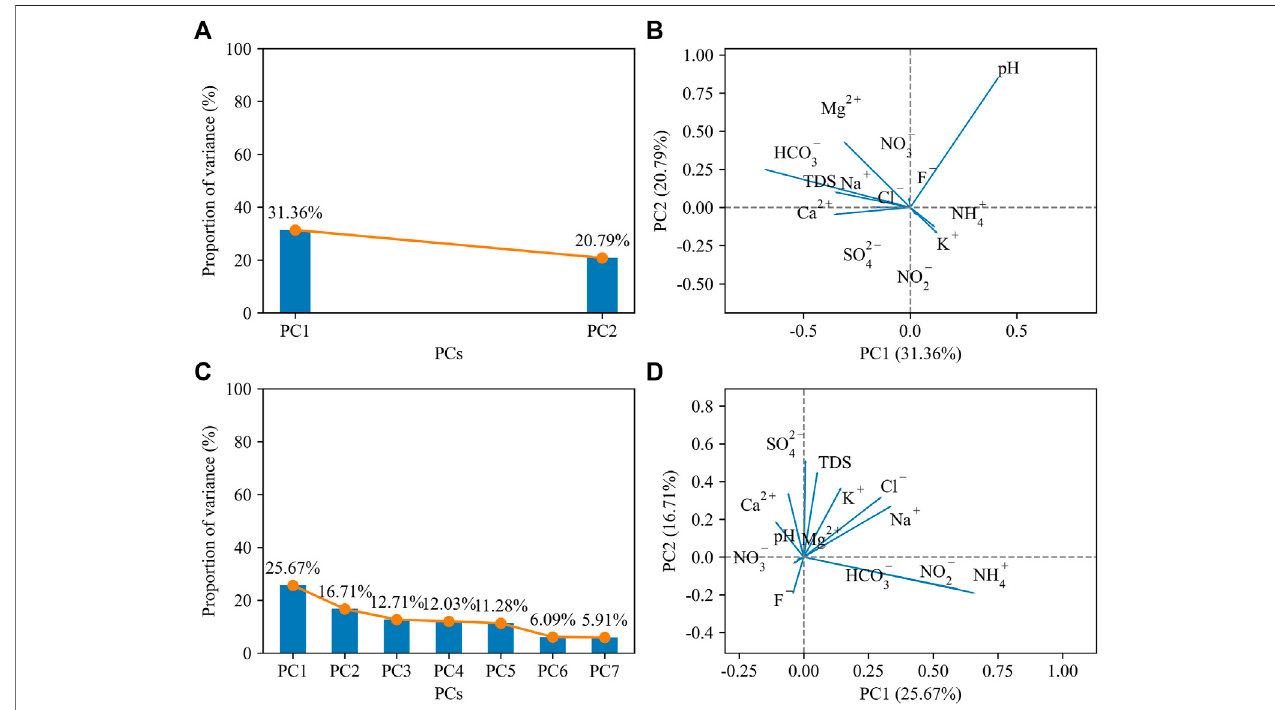
FIGURE4| TheresultsofthePCA. (A) Theaccumulatedvarianceofthetwoprincipalcomponents. (B) Thebiplotofcluster1. (C) Theaccumulated varianceofthe seven principal components. (D) The biplot of cluster 2.